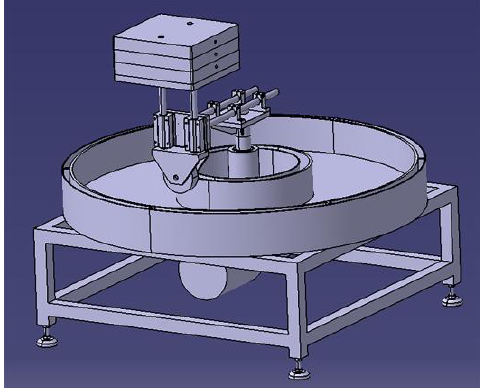
Figure 3. The RSCT Figure 3. The RSCT tester.